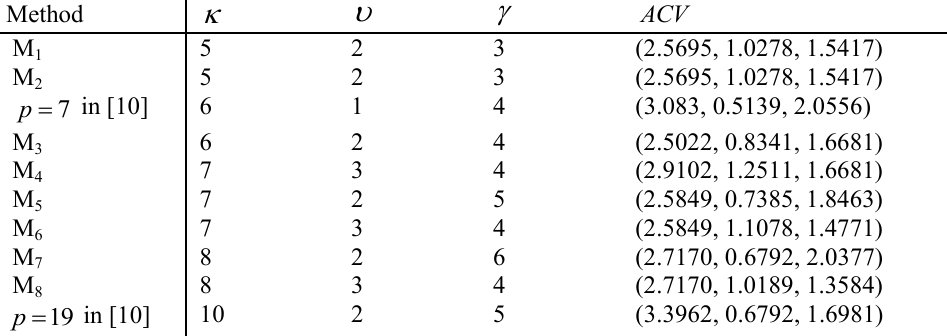
Table 1. ACV for the proposed family of methods (10) and for the methods from the literature [10], [11] and [12] of the orders p=7,11,15,19